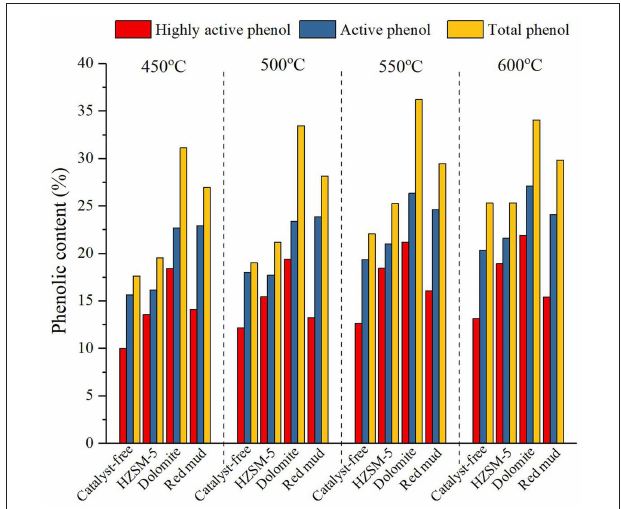
FIGURE 4 | Content of active phenols and total